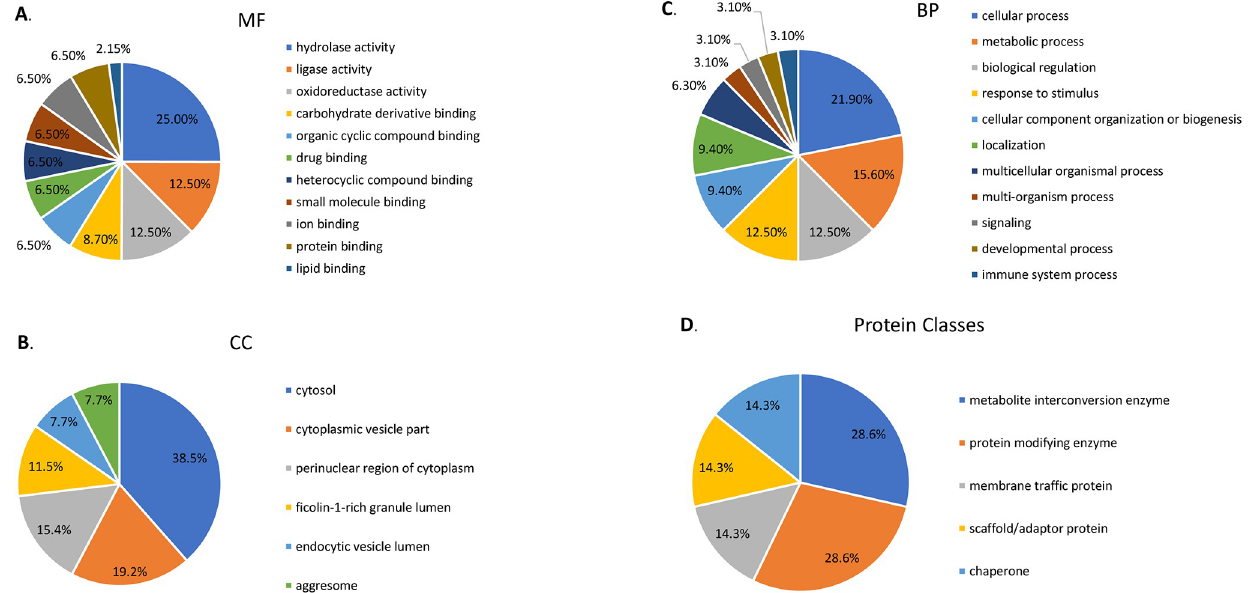
Fig 5. Gene ontology annotations in terms of molecular function (MF) (A) , cellular components (CC) (B) , biological processes (BP) (C) , and protein classes (D) for the 12 differentially expressed proteins identified in PBMCs from patients with pulmonary